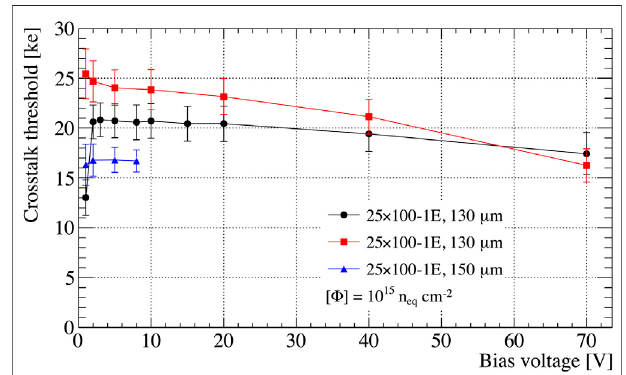
FIGURE 13 | Cross-talk threshold as a function of the bias voltage for RD53A modules with 25 × 100 − 1E FBK sensors with different thickness (second and third batches).